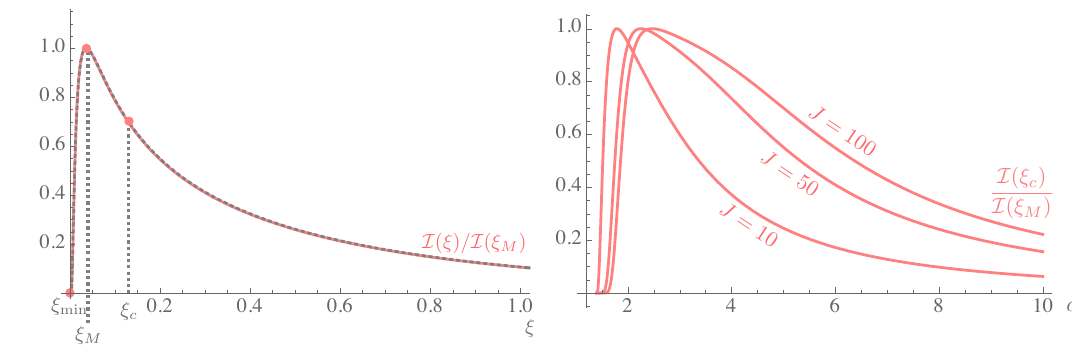
, v = M 5 and ∆ v = 0 . 1 implying UV / UV v as a function of I ( ξ M )